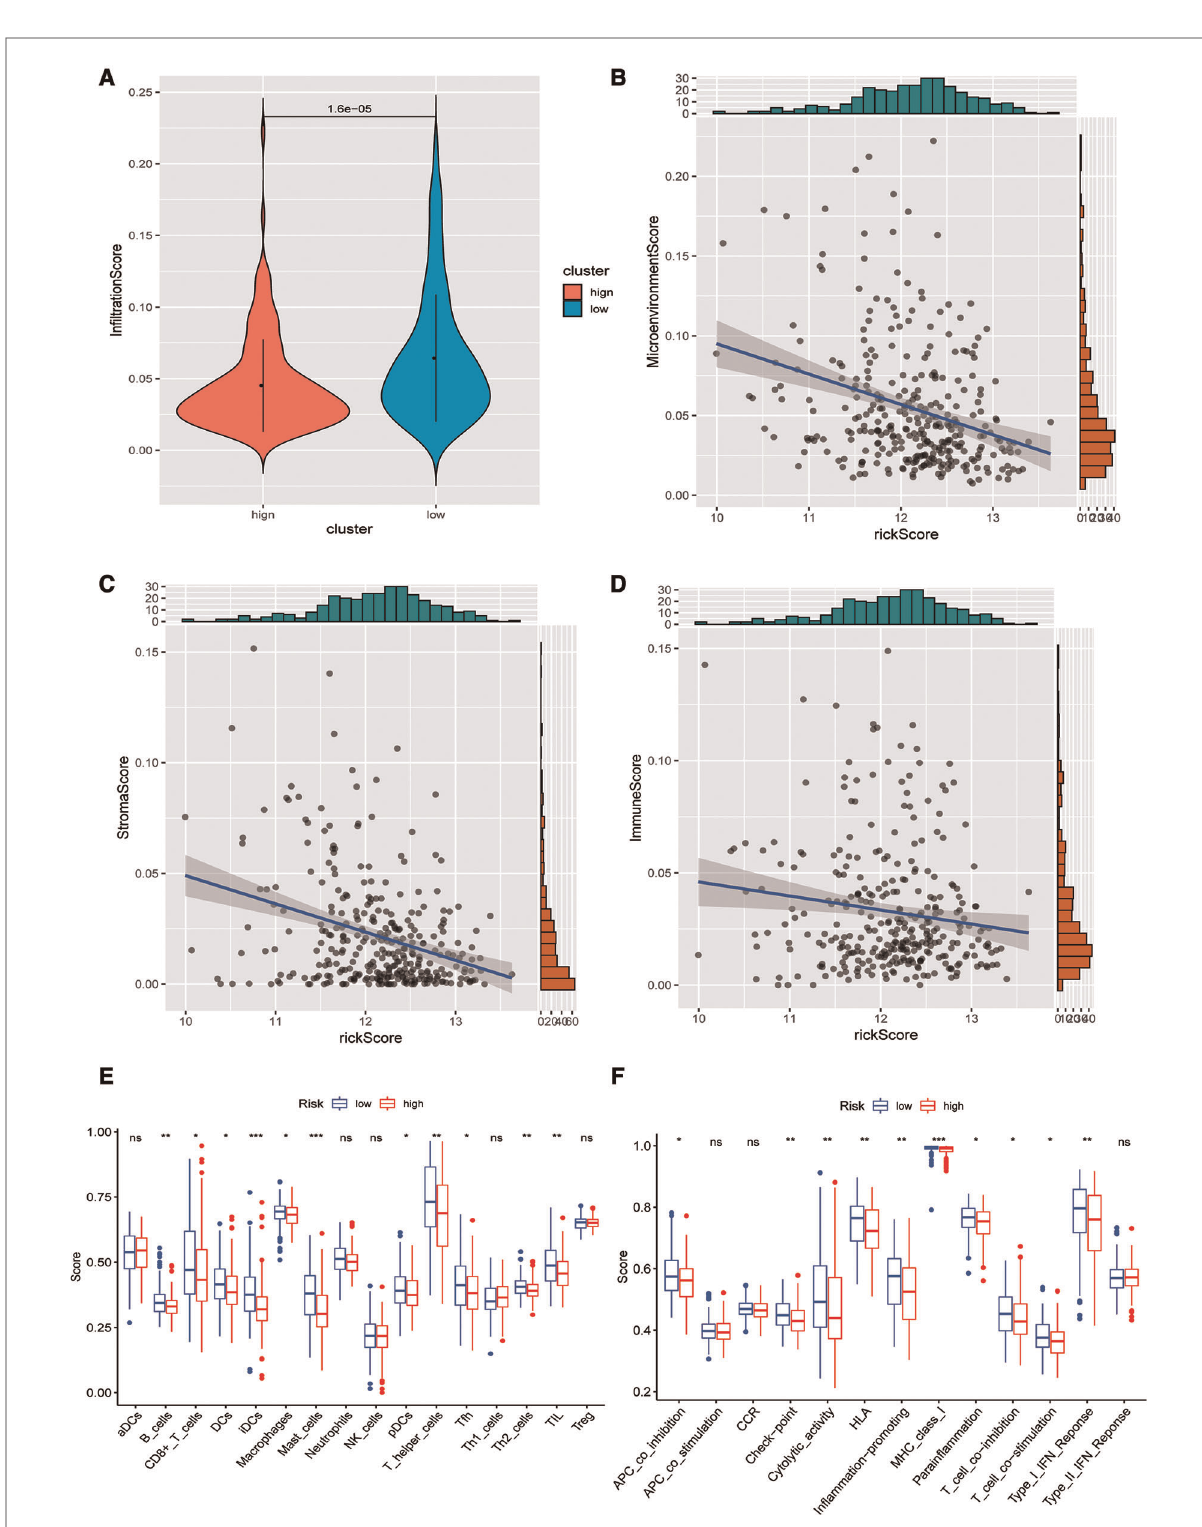
FIGURE 4 Construction and validation of the prognostic model. ( A ) Correlation network diagram of 13 pyroptosis-related key regulators. ( B ) Parameter selection in least absolute shrinkage and selection operator (LASSO) regression. ( C ) Coef fi cient distribution in LASSO regression. Survival analysis based on risk scores in the training set ( D ) and validation dataset ( D ). ( E ) Univariate Cox risk regression considering other clinical factors in the training dataset. ( F ) Univariate Cox risk regression considering other clinical factors in the validation